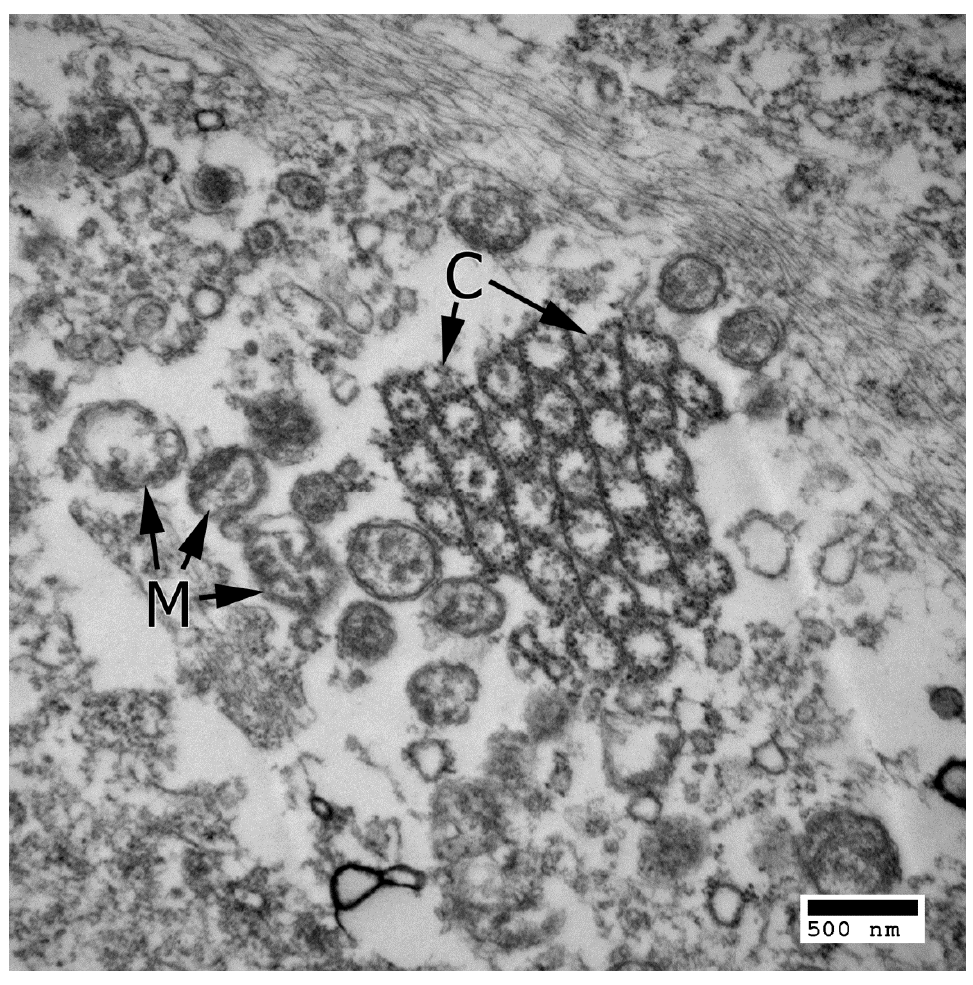
Figure 3. Electron micrograph from a patient with advanced AMD showing extranuclear DNA. Extranuclear chromatin (C) and mitochondrial disintegration (M) is observed. Chromatin strands form vesicles that clump together to form a